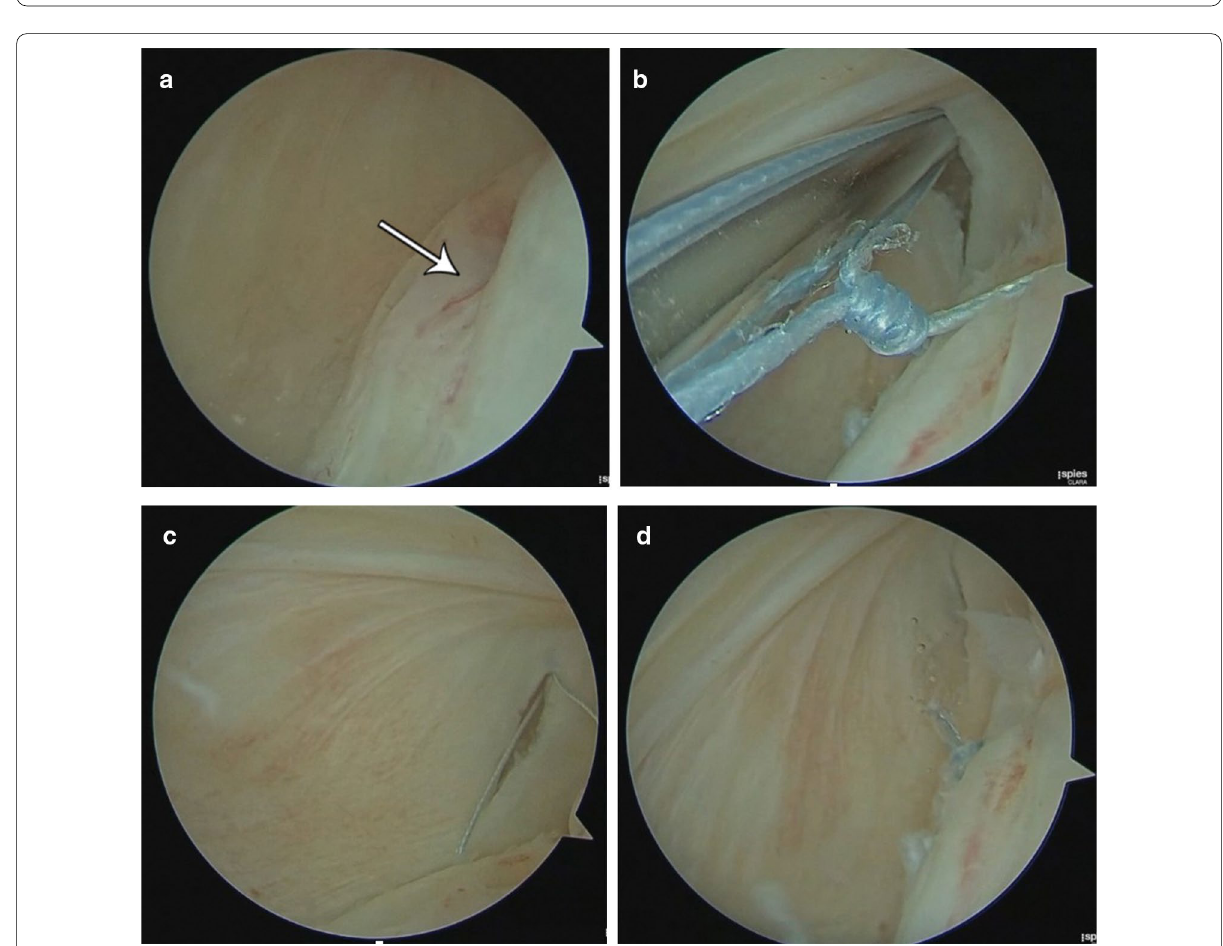
Fig. 16 Arthroscopic images presents intra‑articular diagnosis of a Type 4 ramp lesion through a posteromedial portal ( a ). An all‑inside meniscal repair was performed ( b and c ). Final suture aspect is seen in ( d ). *Case courtesy of Dr. Luis. E. P. Tirico